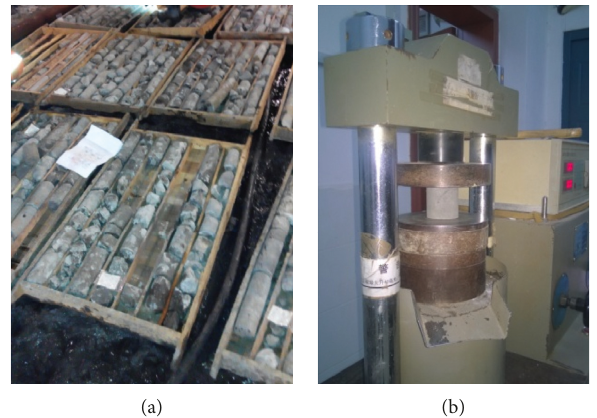
Figure 6: Rock mechanical parameters experiment. (a) Site core test. (b) Mechanical experiment.